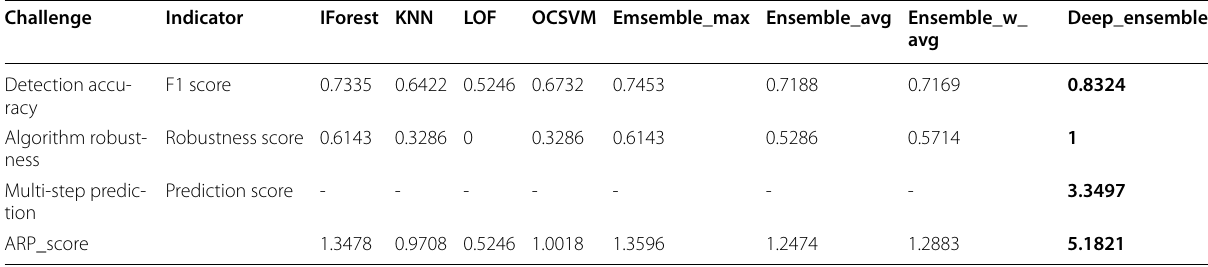
Table 7 Comparison results of all detection